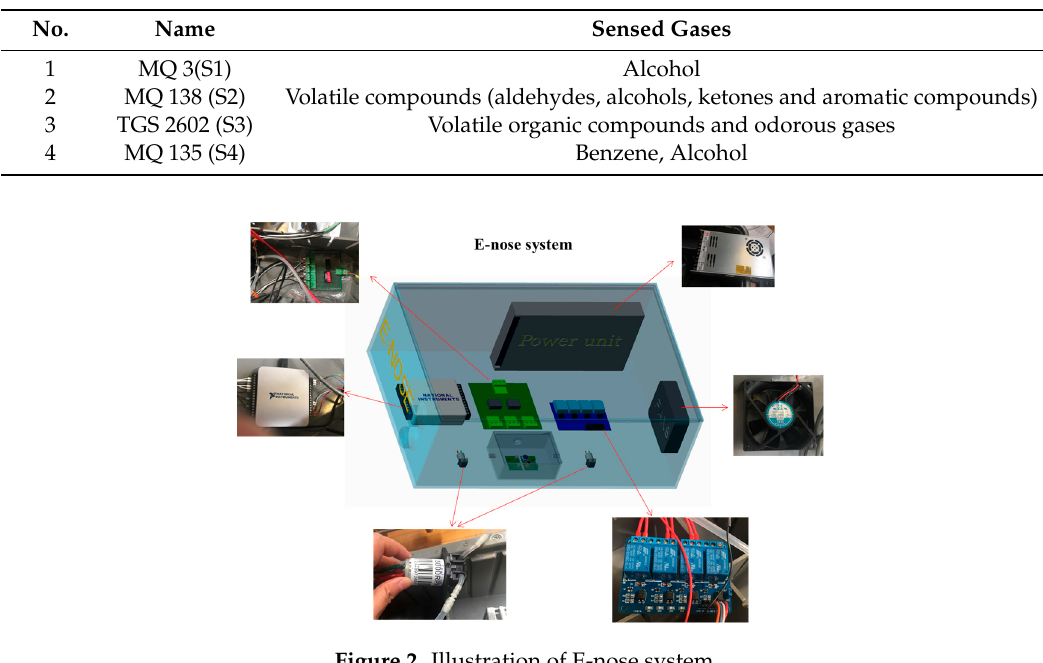
Table 1. Gases detected by each sensor employed in the E-nose system.